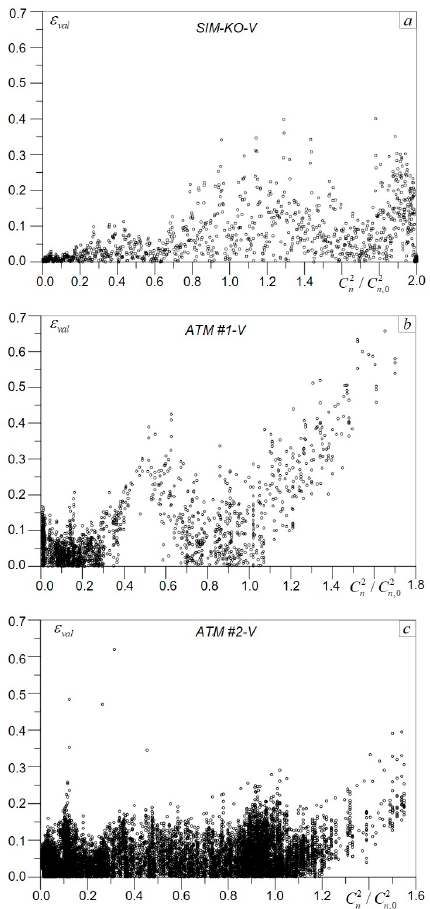
Figure 8. C 2 n prediction errors ε val ( c 2 n ) (Equation (3)) obtained with Cnˆ2Net processing of SIM-KO-V Figure 8. 2 n C prediction errors 2 ( ) val n c ε (Equation (3)) obtained with Cn^2Net processing of SIM- KO-V ( a ), ATM #1-V ( b ) and ATM #2-V ( c ) data subsets ( 2 14 2/3 ,0 1 10 m n C − − = ⋅ ). ( a ), ATM #1-V ( b ) and ATM #2-V ( c ) data subsets ( C 2 The prediction errors averaged across the entire 2